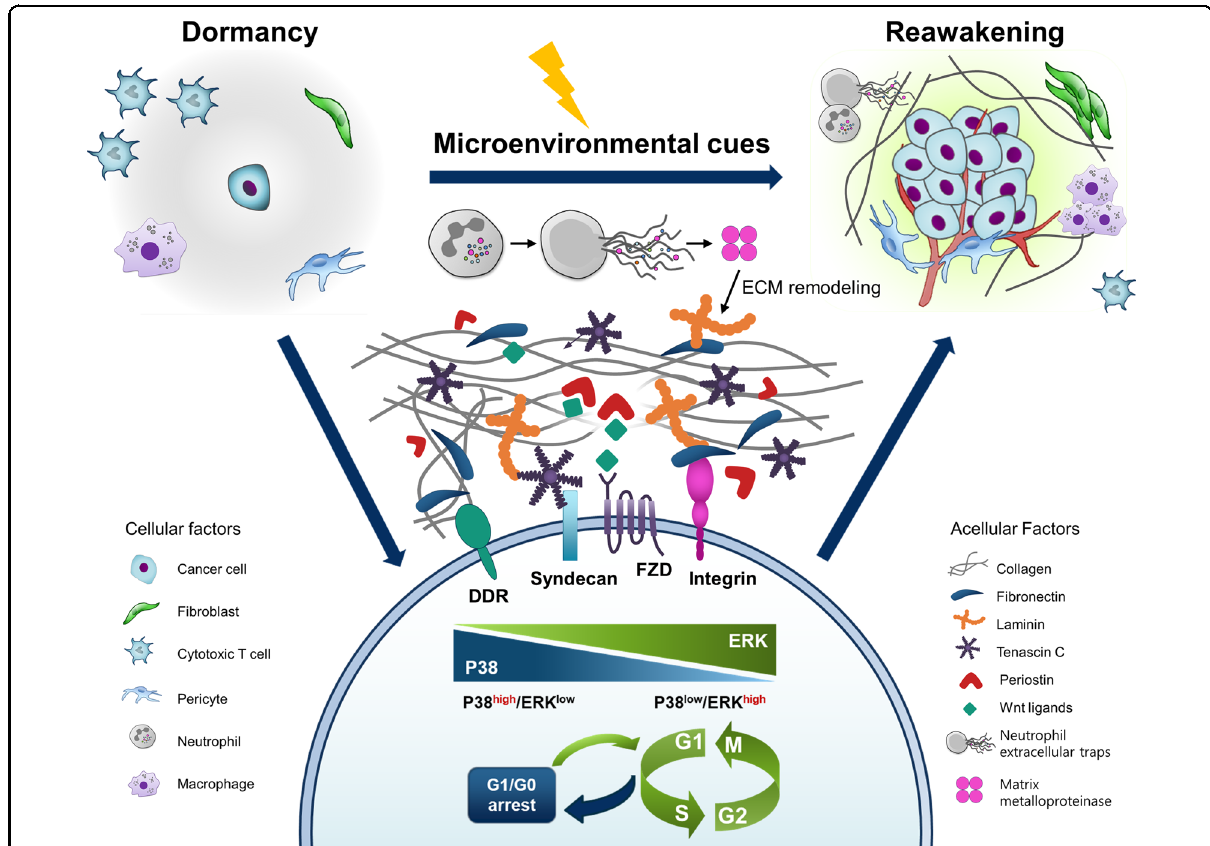
Fig. 1 Schematic view of cellular and acellular factors that reawaken dormant cancer cells. Cancer cells often enter dormancy to evade immune attack. Once in a new location, these dormant cancer cells (DCCs) receive signals from the surrounding tissue, thereby gain the ability to re- enter the cell cycle. Also, chronic in fl ammation can reactivate DCCs, which can trigger tumor development. Key signaling components involved in DCC reactivation are currently being investigated and may help to fi ght this leading cause of death from cancer. ECM, extracellular matrix; DDR, discoidin domain receptor; FZD,